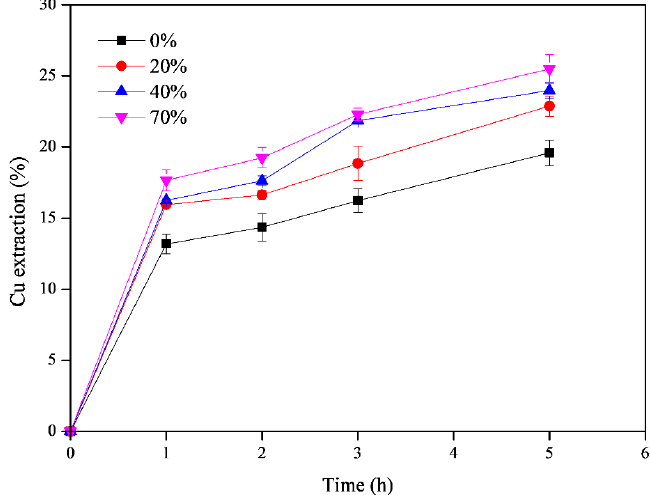
Figure 5. Copper extraction versus leaching time without (0%) and with ultrasound assistance at three power amplitudes (leaching conditions: a 10% solid-to-liquid ratio (S/L), 0.5 M sulfuric acid three power amplitudes (leaching conditions: a 10% solid-to-liquid ratio (S / L), 0.5 M sulfuric acid concentration, 50 °C, and 800 rpm stirring speed). concentration, 50 ◦ C, and 800 rpm stirring